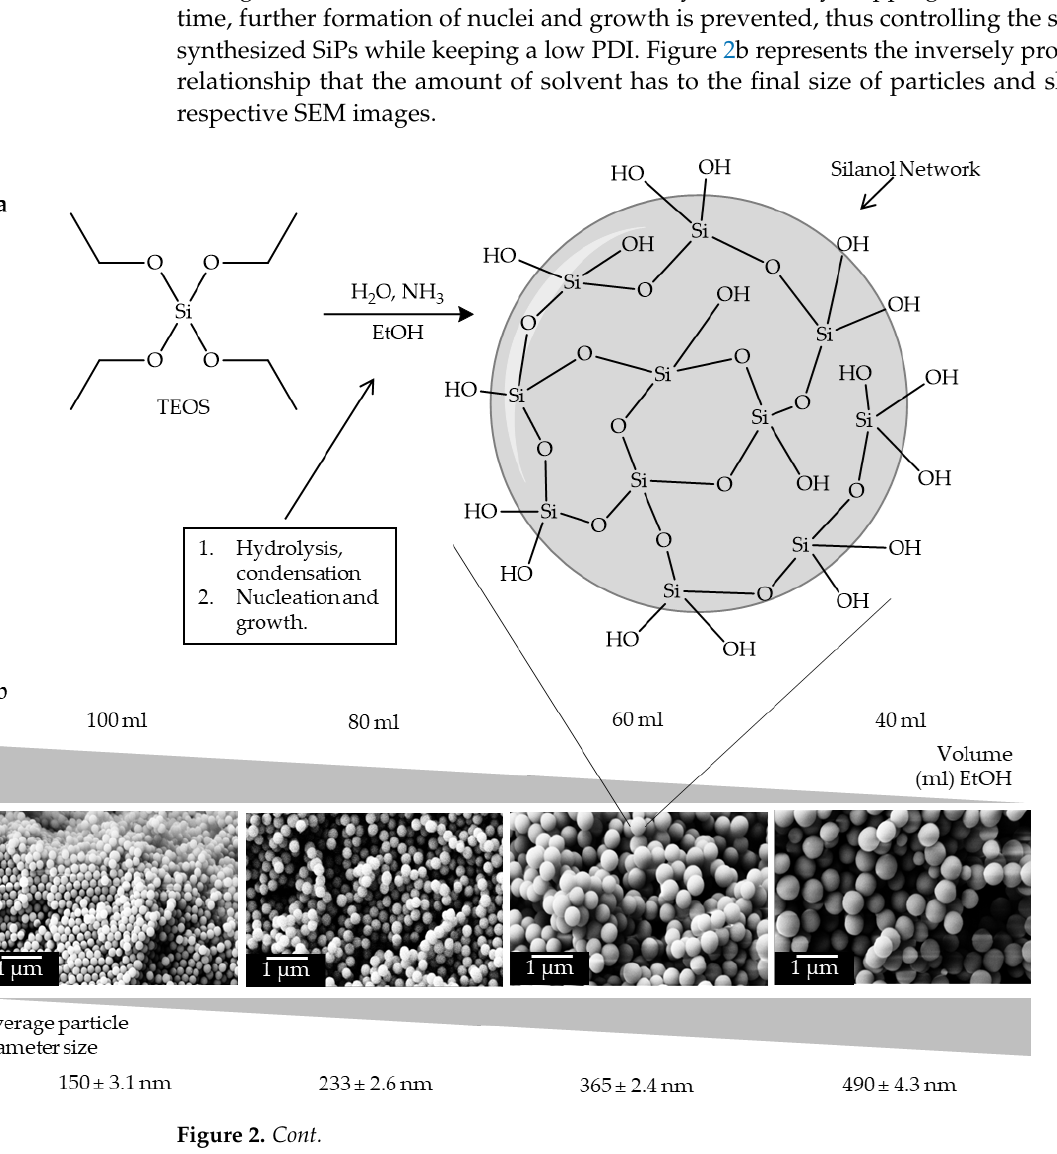
Figure 2. Synthesis and characterization of the SiPs. ( a ) Scheme of the SiPs synthesis. After the ad- hesion of TEOS to the ethanol solution, hydrolysis takes places promoting the formation of the si- lanol network. This in turn starts the nucleation for the formation of the SiPs. ( b ) SEM images of the obtained SiPs, and the representation of the inversely proportional relationship between the amount of EtOH and the final diameter of the SiPs. ( c ) Hydrodynamic sizes of the SiPs measured via DLS. The hydrodynamic diameter is usually a higher value than the diameter since it refers to moving particles in a solution.